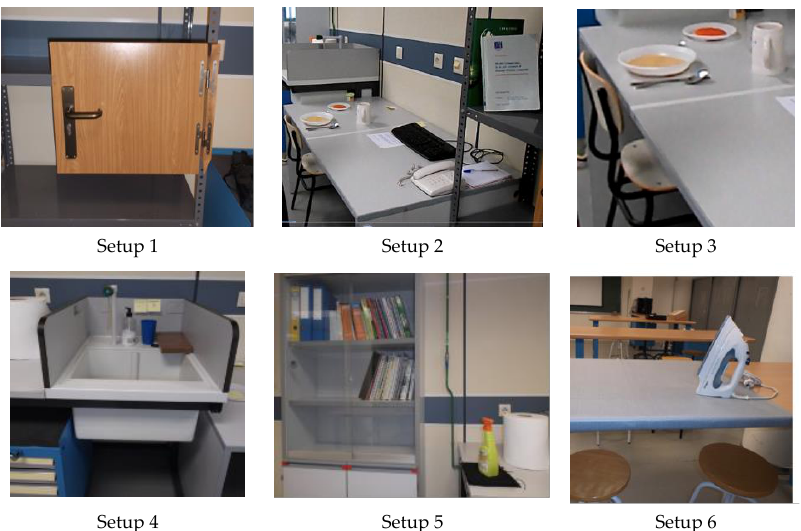
Figure 1. Setups arranged in the laboratory to perform the 21 selected activities of daily living (ADL).